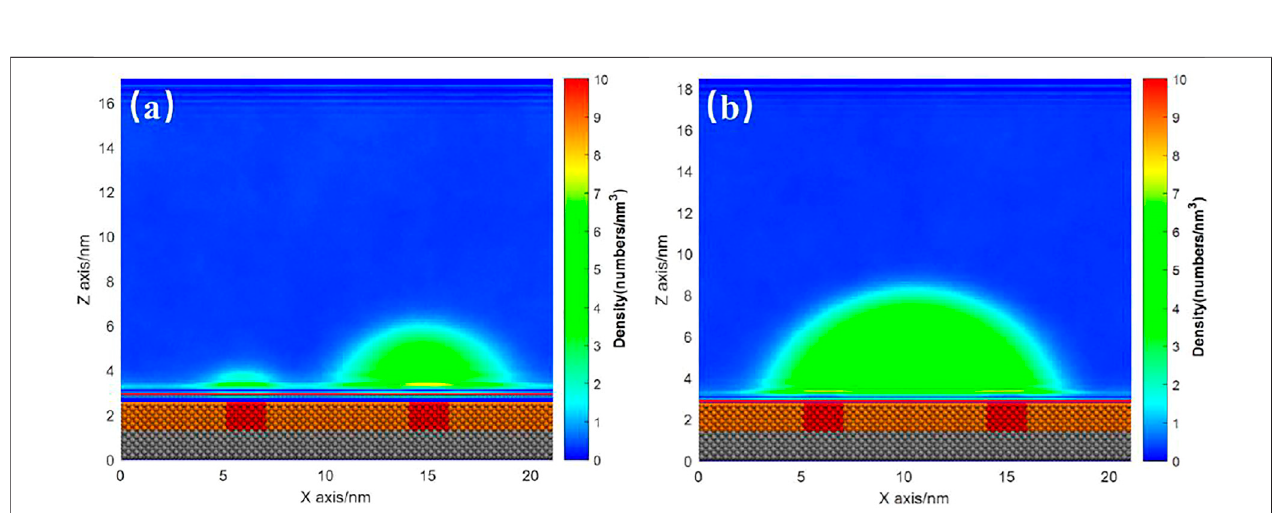
FIGURE 10 | Time-averaged gas density distribution map for substrate with two patches under gas density number of (A) 600 and (B) 1,000. Both the liquid particle number is 15,000. A movie for the process of (B) is available as Supplementary Video S3 .